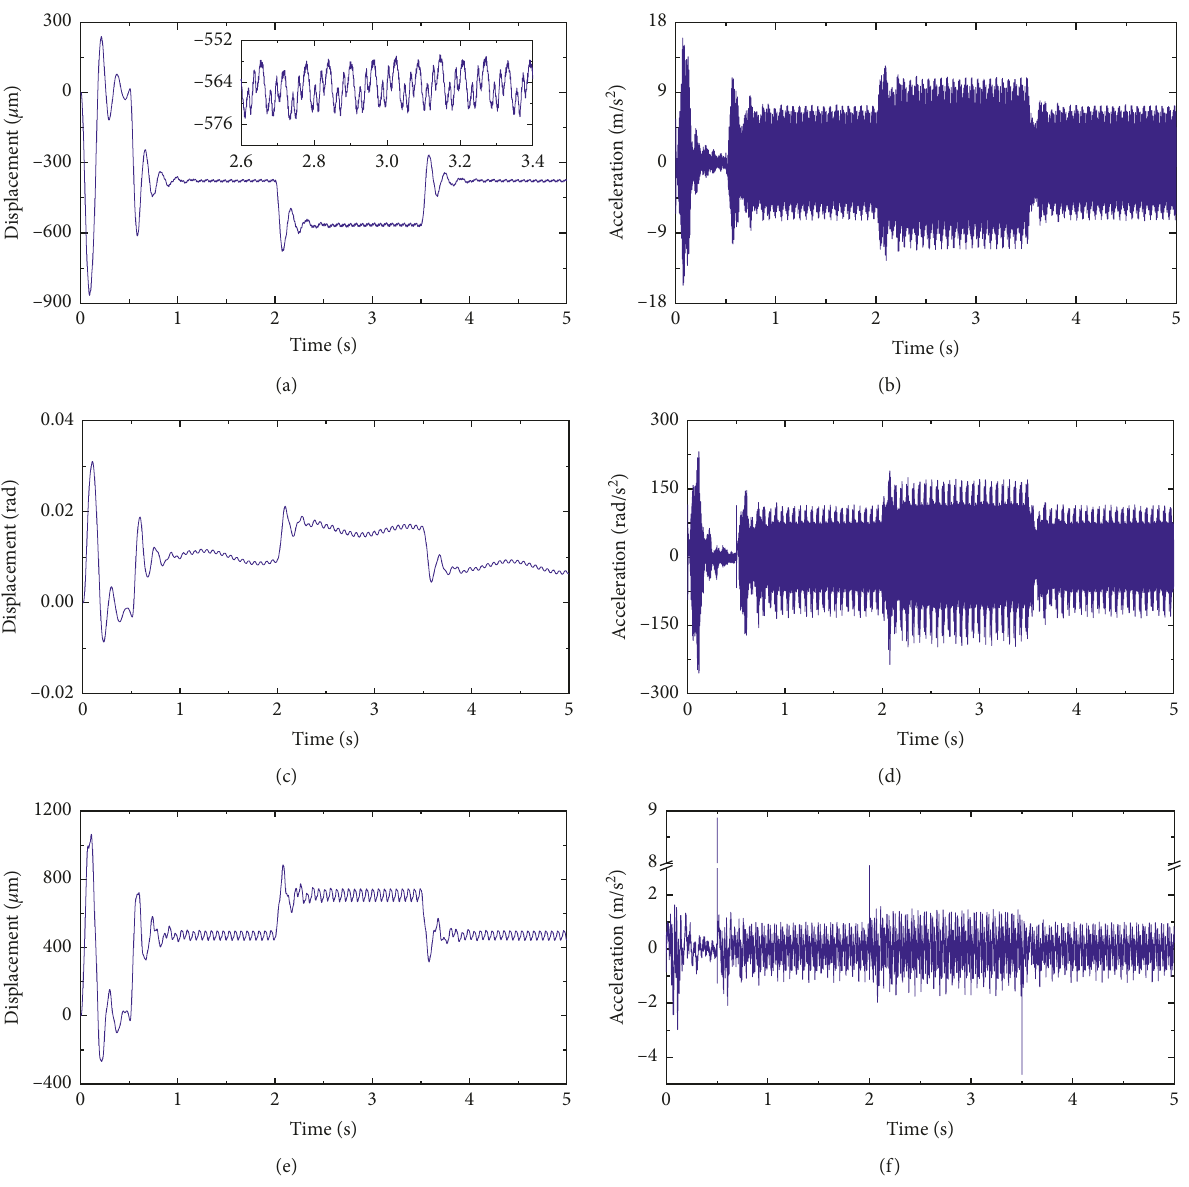
Figure 14: Vibration displacements and accelerations. (a) Reducer shell displacement in direction y . (b) Reducer shell acceleration in direction y . (c) 2nd drive gear angular displacement. (d) 2nd drive gear angular acceleration. (e) Drum displacement in direction y . (f) Drum acceleration in direction y